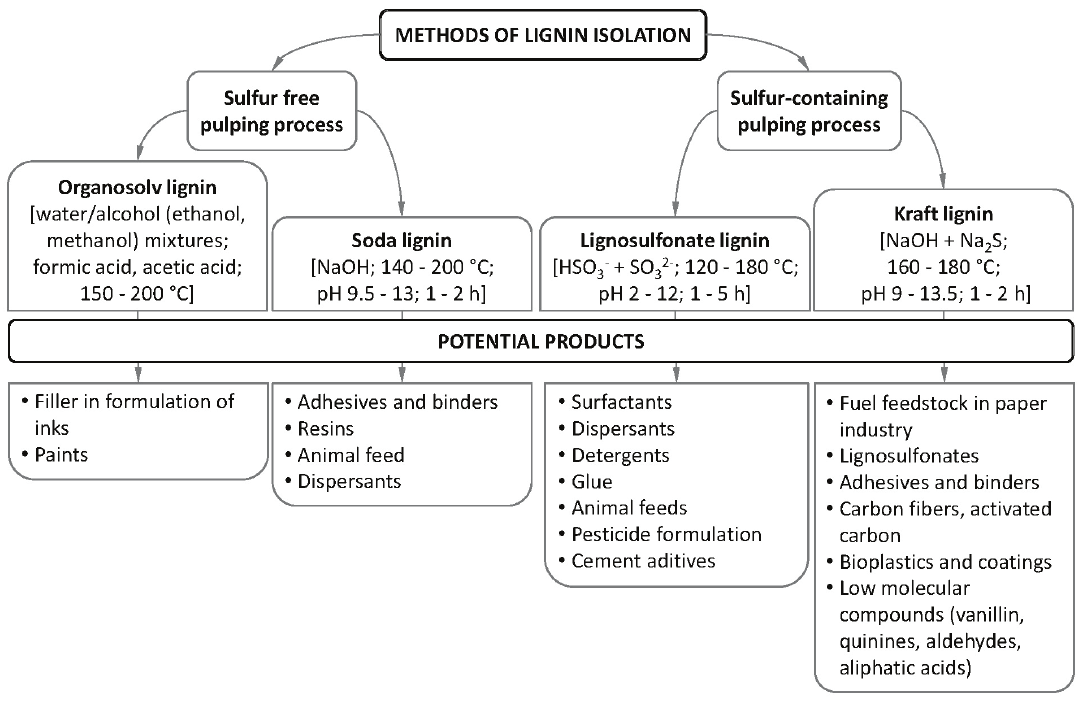
Fig. 4 – Type of lignin based on the methods of isolation and potential bioproducts from